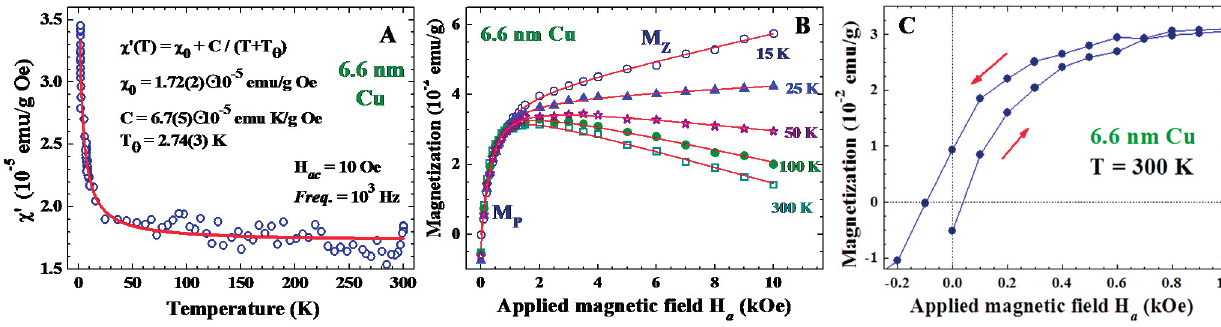
Figure 2. ( A ) Temperature dependencies of the in-phase component χ ʹ of the ac magnetic susceptibility of 6.6 nm Cu nanoparticle assembly, measured employing a driving ac magnetic field with a root-mean-square strength of 10 Oe and a frequency of 10 3 Hz. The solid curve indicates the fit to the Curie-Weiss thermal profile; ( B ) isothermal magnetization curves of the 6.6 nm Cu particle assembly, taken in field-increasing loops at five representative temperatures. The solid curves indicate the results of the fit to the field profile discussed in the text; and ( C ) magnetic hysteresis loops of the 6.6 nm Cu assembly at 300 K, revealing a coercive field of 100 Oe and a remanence of 9.4 × 10 − 3 emu/g. The red arrows indicate the directions of the field-changing